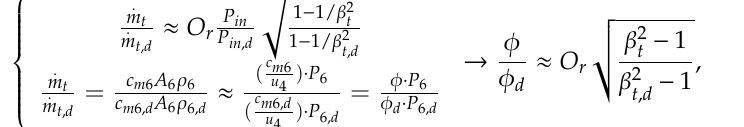
ff ect of design guide vane outlet flow angle on the change characteristics of W Figure 5. Effect of design guide vane outlet flow angle on the change characteristics of Figure 5. E pressure ratio change ( β 6 m = − 52.5 ◦ , β 4 = − 30 ◦ , β t , d =